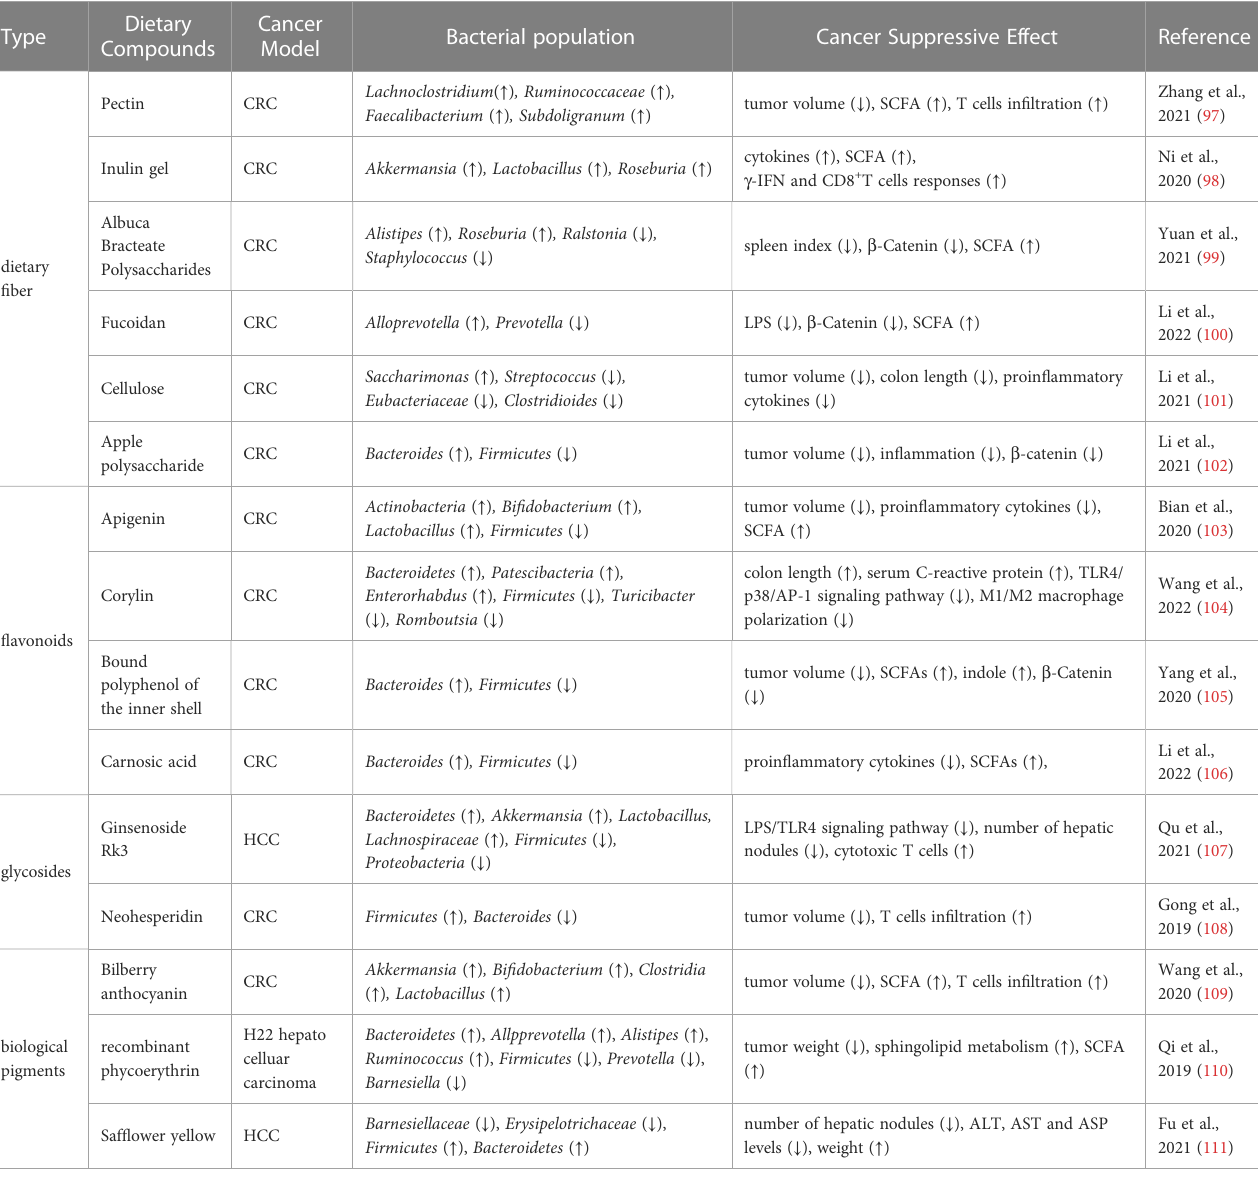
Arrows ↑ or ↓ represent up-regulation or down-regulation.